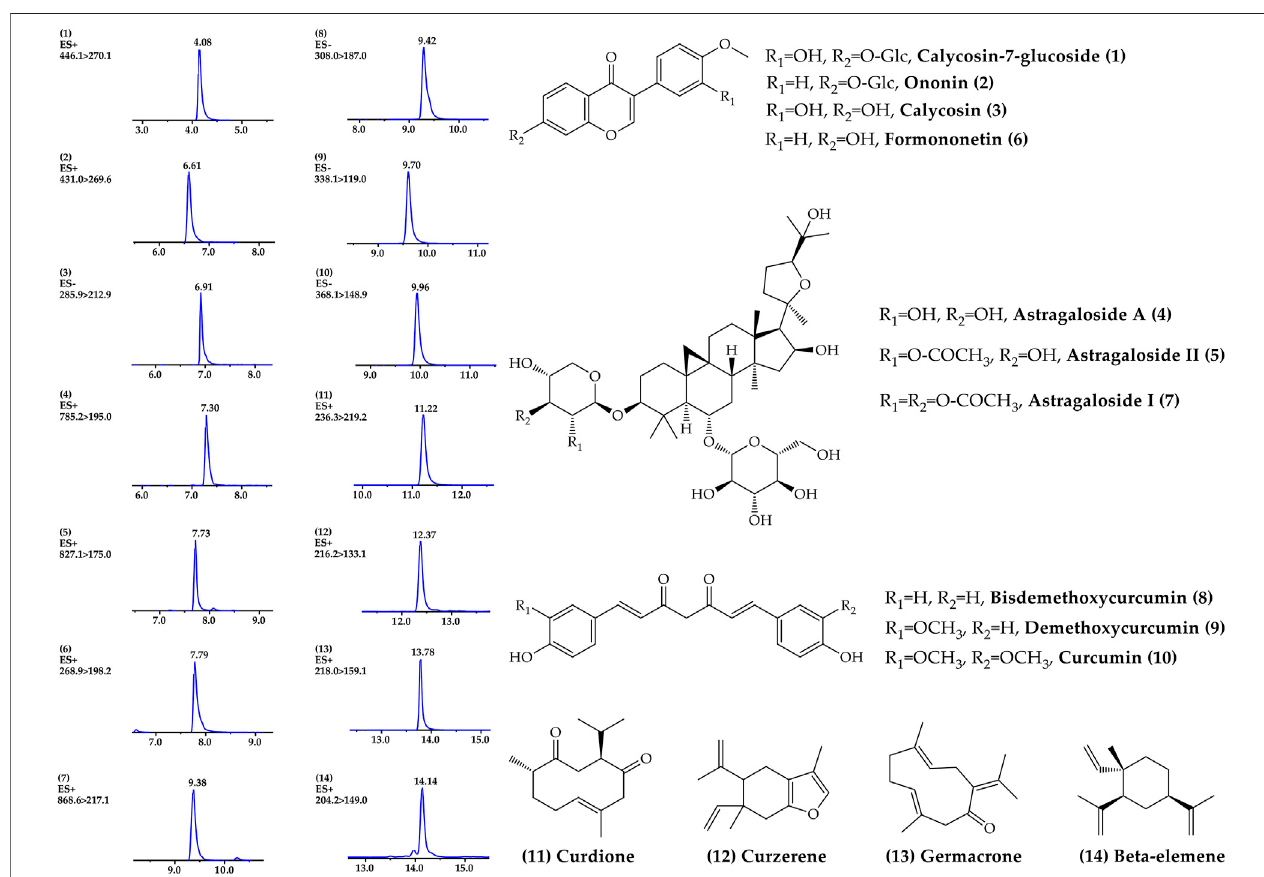
FIGURE 1 | Chemical pro fi le of Astragalus mongholicus Bunge- Curcuma aromatica Salisb. extract detected by UPLC – MS/MS.